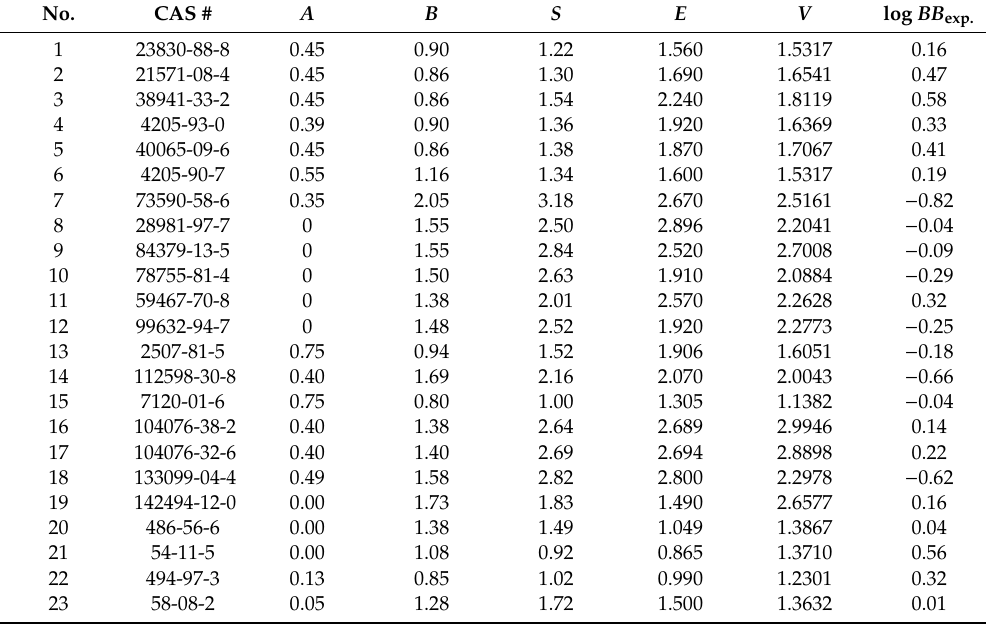
Table 3. Experimental log BB values [43] and molecular descriptors ( A , B , S , E , V ) calculated using ACD Percepta for a training set of